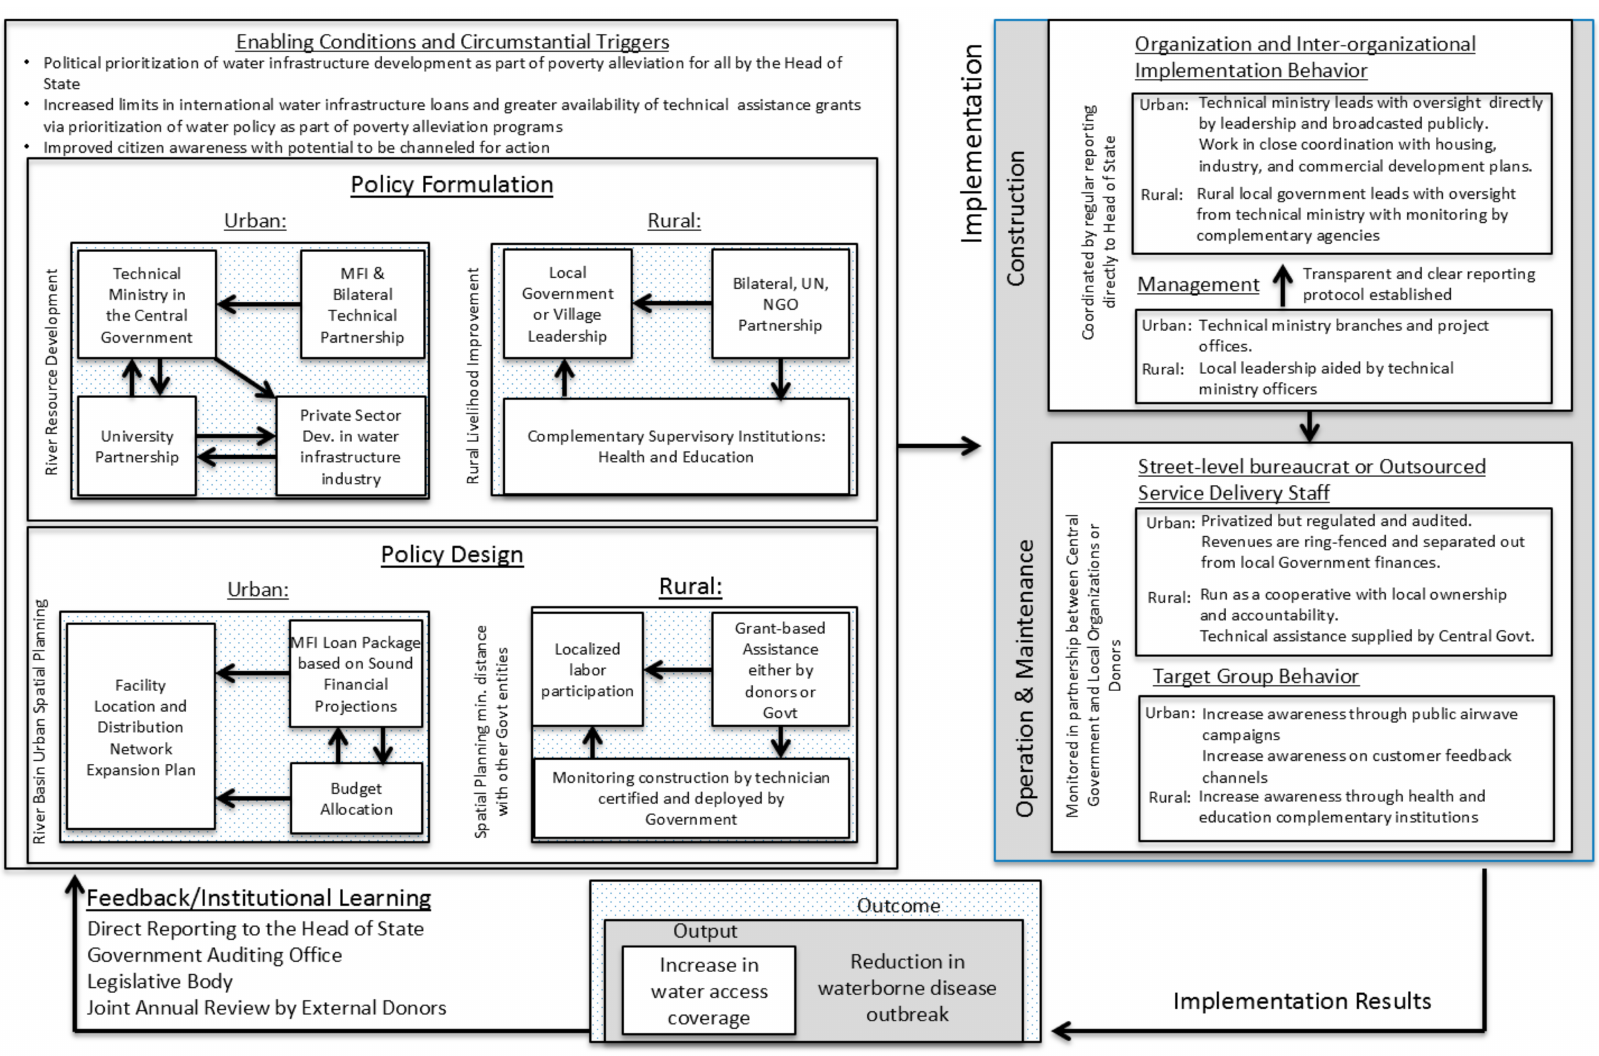
Figure 6. State-Implementation Synthesis Framework for Catalyzing Access to